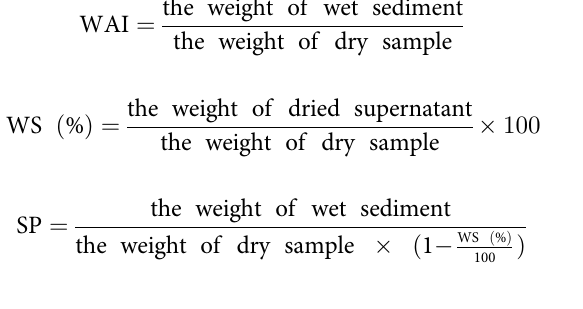
The speed of screw was 150